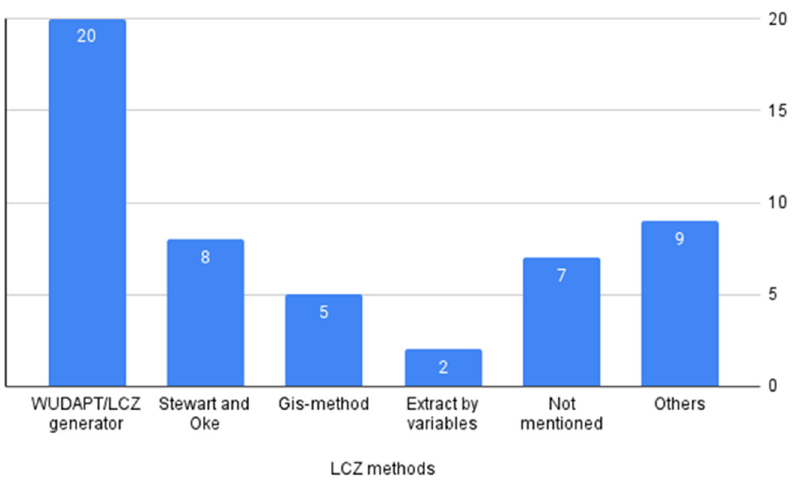
Figure 10. Methods of LCZ calculation.